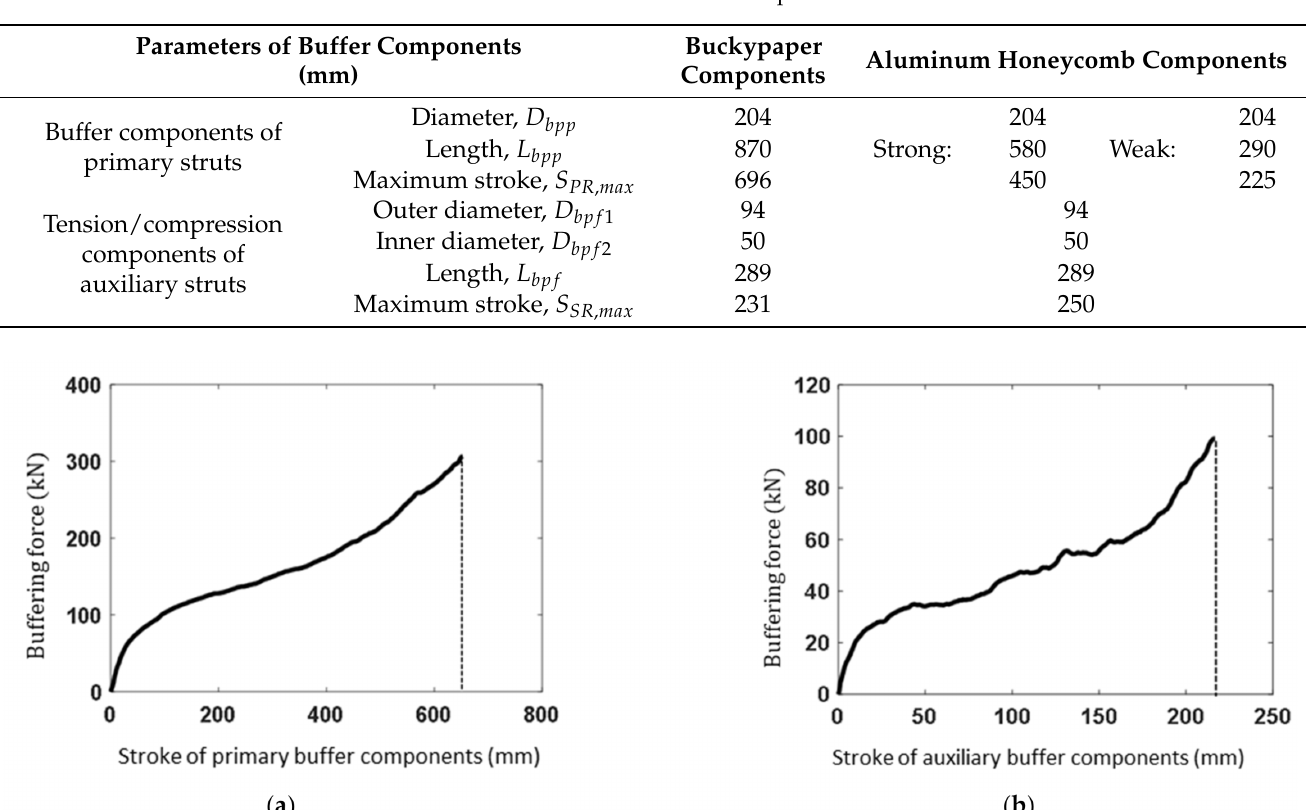
Table 3. Parameters of buffer components.